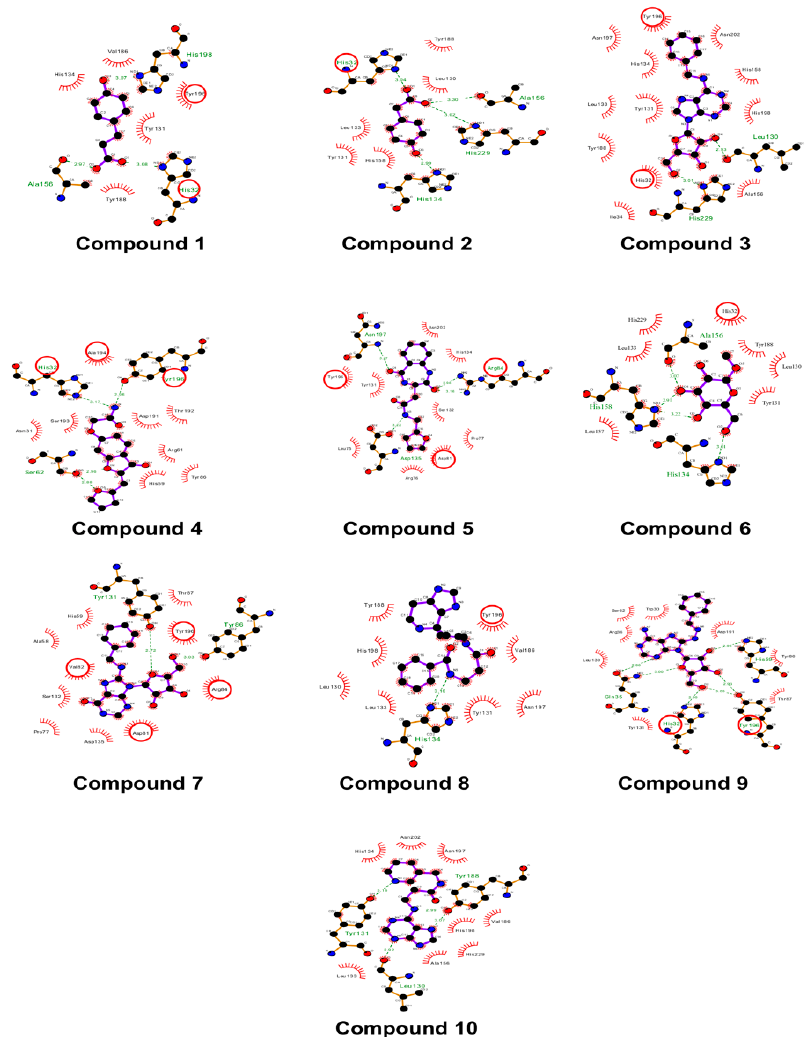
Figure 4. The 2D interaction diagram. The docked poses display interactions in the SAM and m 7 GTP binding site of the predicted model of HEV-MTase protein. In the diagrams, residues highlighted in the red circle are common SAM and m 7 GTP binding residues in the HEV-MTase complexes. Sidechains of interacting residues of the HEV-MTase protein are shown as sticks in pink colour.